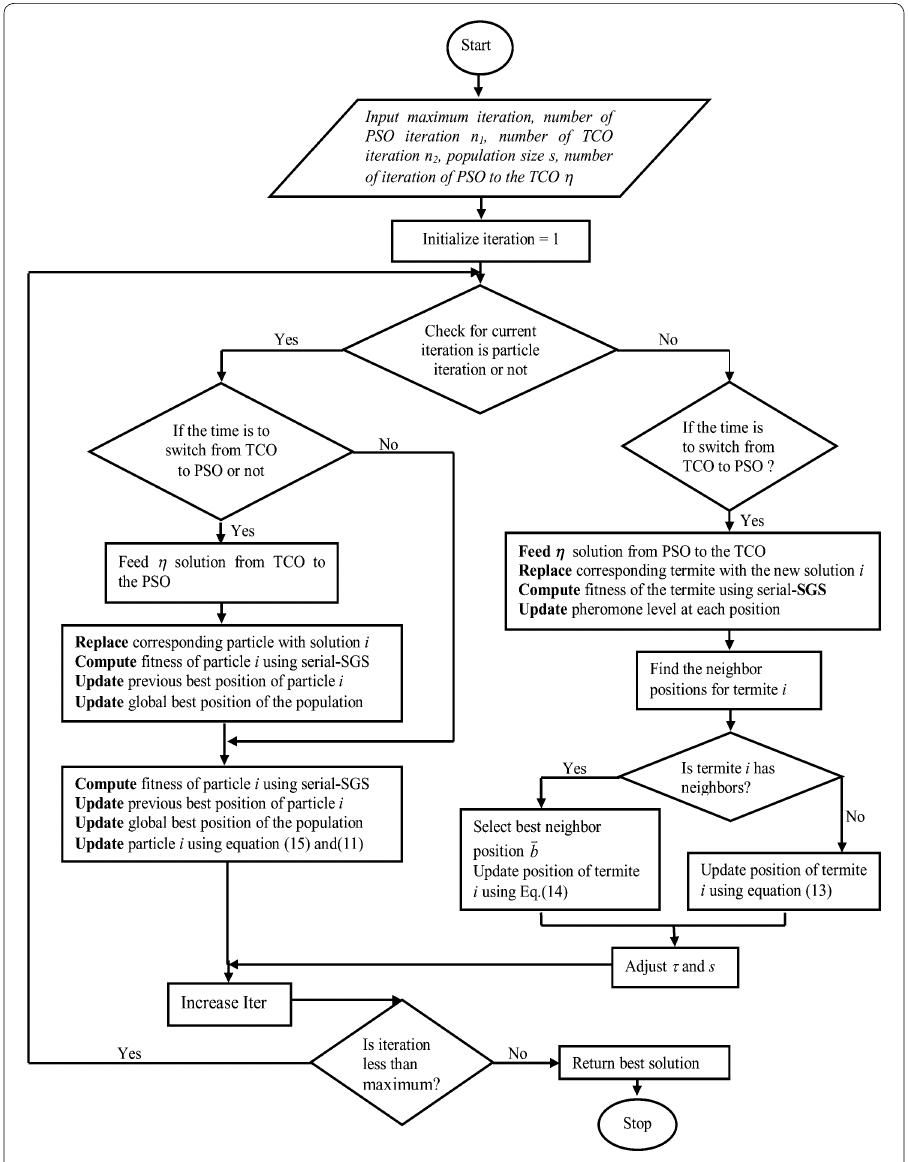
Fig. 1 Flowchart of the proposed HPSTCO